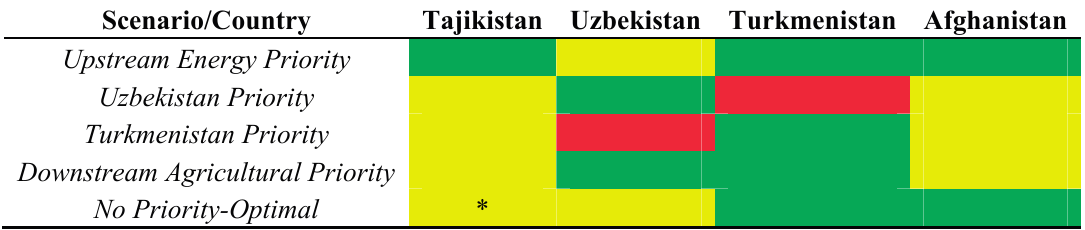
Table 3. Preferable scenarios for the riparian countries in terms of total economic benefits as derived from the model (green—desirable, yellow—acceptable,